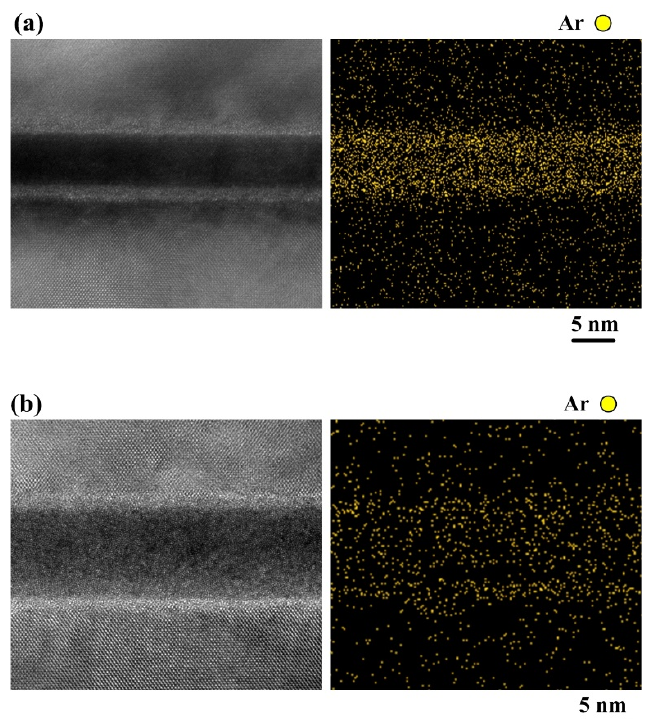
Figure 8. High-magnification cross-sectional TEM and high-resolution EDS mapping images of the bonding interfaces in the two bonded Si-Si specimens activated under the Ar ion beam currents of ( a ) 10 mA and ( b ) 30 mA.